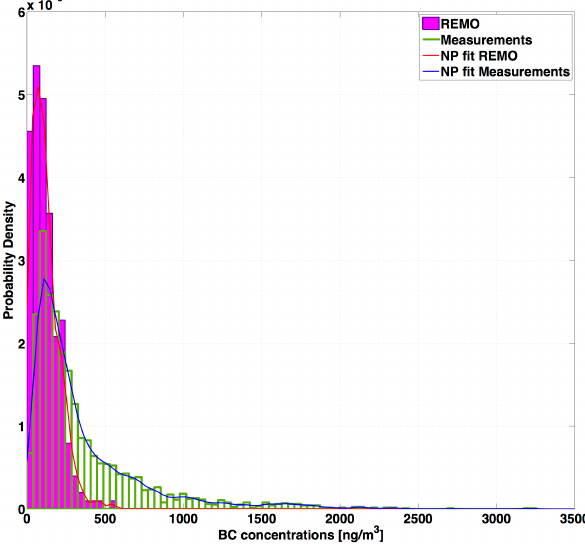
Fig. 7. The histograms (pink: REMO; and green: measurements) and the probability density functions (pink: REMO; and blue: mea- surements) of the black carbon concentration for the entire experi- mental period (Hyyti¨al¨a,